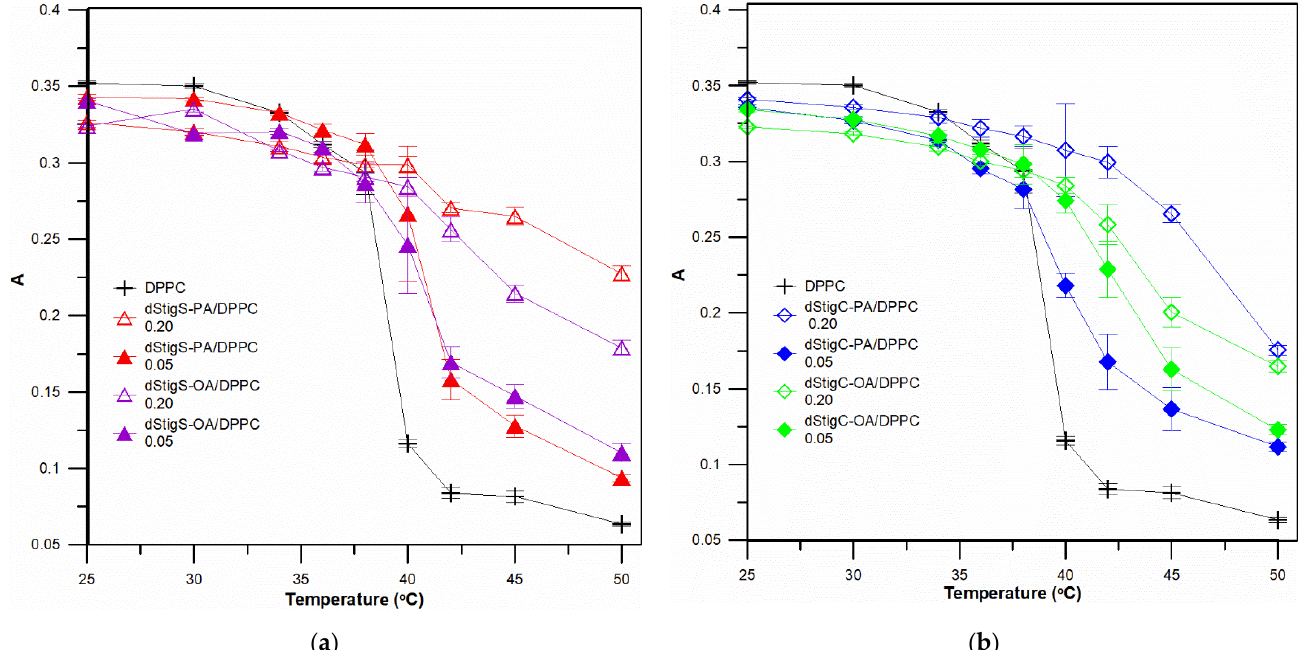
Figure 4. Values of fluorescence anisotropy of the DPH probe for different concentrations of the tested compound in the lipid membrane. Measurements made at two temperatures 25 and 45 °C for SUVs formed from DPPC and dStigMAs.